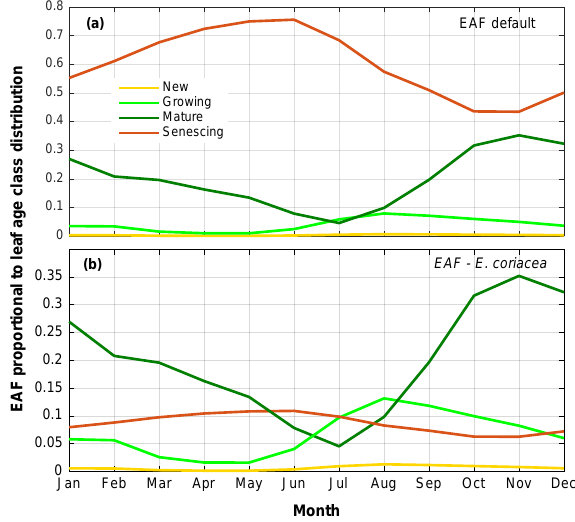
Figure 6. (a) Emission activity factor (EAF) of isoprene for each leaf age class assigned in the default mode of MEGAN 2.1 propor- tional to leaf age class distribution derived from field observations (CAMERA-LAI). (b) Isoprene EAF for each leaf age class obtained from leaf-level measurements of the tree species E. coriacea , pro- portional to leaf age class distribution derived from field observa- tions (CAMERA-LAI). Observations of the tree species E. coriacea (Alves et al., 2014) and CAMERA-LAI are both from the K34